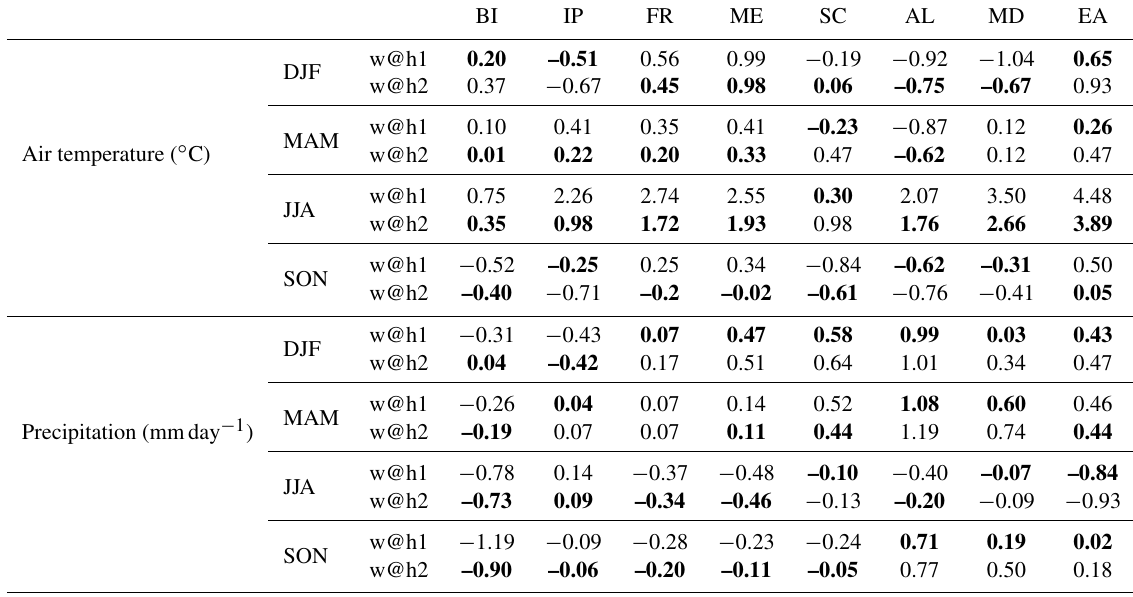
Table 2. HadRM3P biases in regionally averaged temperature and precipitation for the eight regions shown in Fig. 1. The numbers in bold font indicate better performance in the corresponding model version for each region, season, and variable.